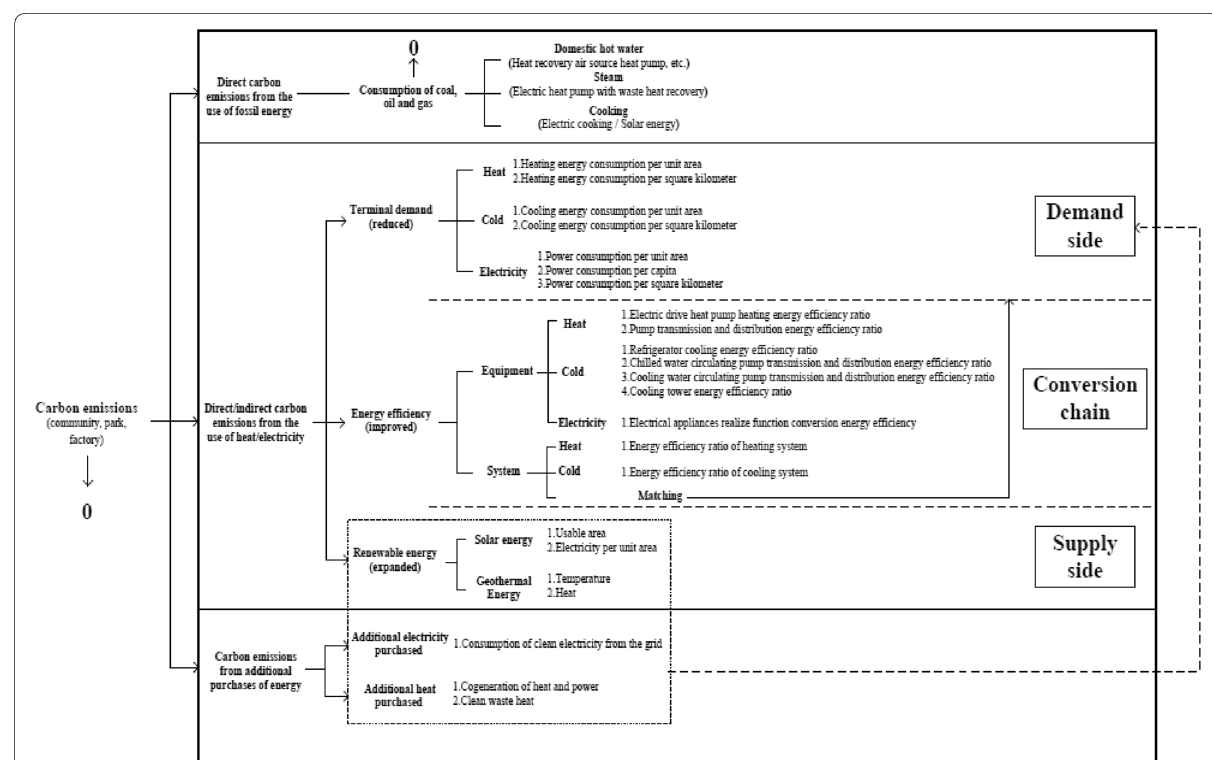
Fig. 4 Implementation path and indicator system of decarbonization in the public building